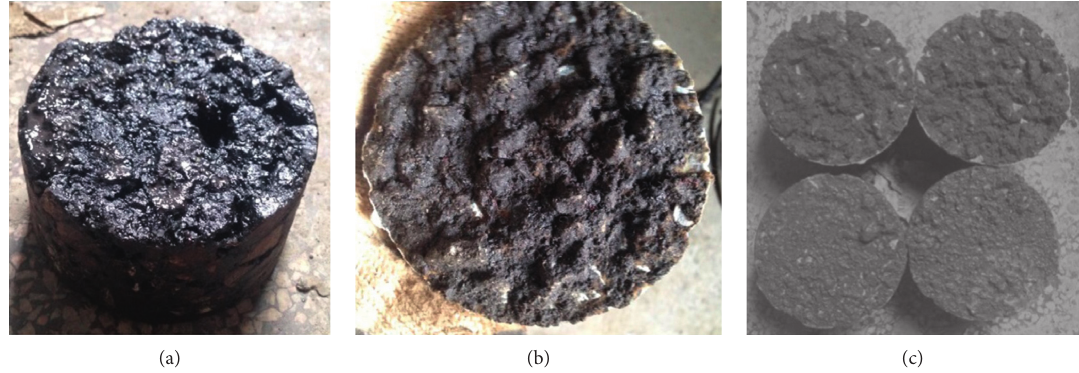
Figure 29: Interlaminar shear failure surface for EA-based prime coat (a, b) and common prime coat (c) [64].